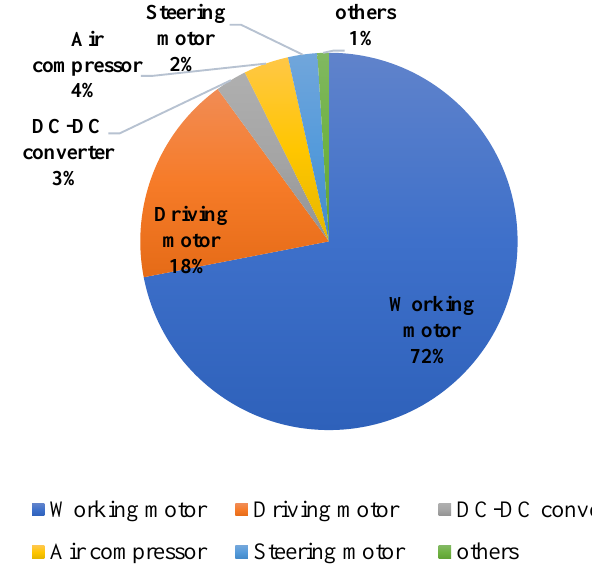
Figure 6. Energy consumption proportions of the devices